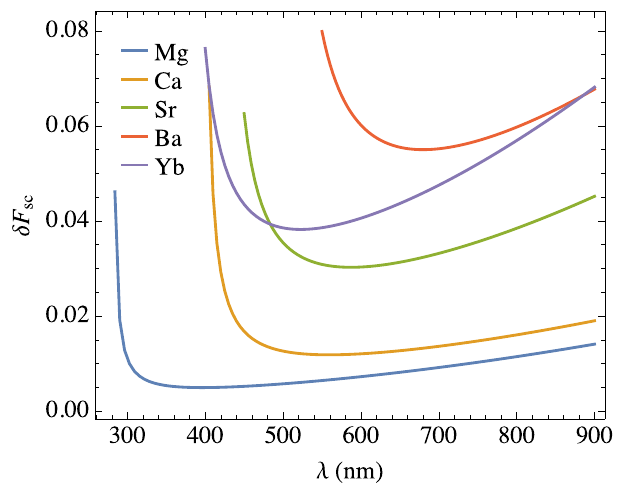
FIG. 11. Infidelity due to spontaneous scattering for (cid:14) = 0.07, = 0.4, and ω = 2 π × 3 MHz for different atomic species. ν 0 x The steep slope at short wavelengths is caused by the excessive scattering close to the resonance of the S ⇔ P transition. At long wavelengths, the infidelity increases due to an enlarged spot size for a diffraction limited spot for the assumed numerical